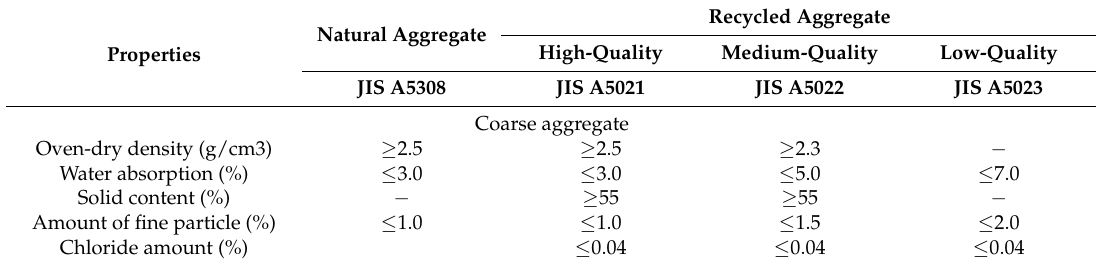
Table 3. Classification of the recycled aggregate based on the Japanese Industrial Standards